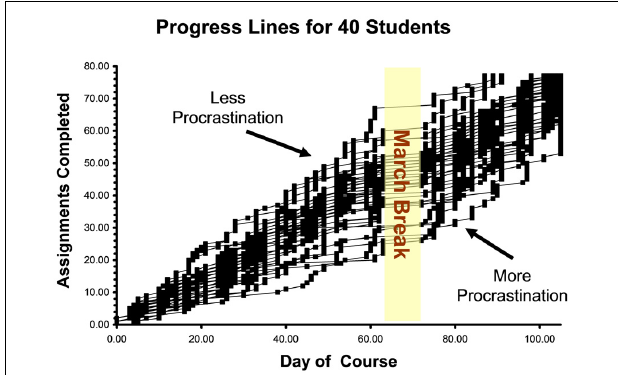
FIGURE 1 | Pacing style of a representative student subsample completing 77 course assignments over a